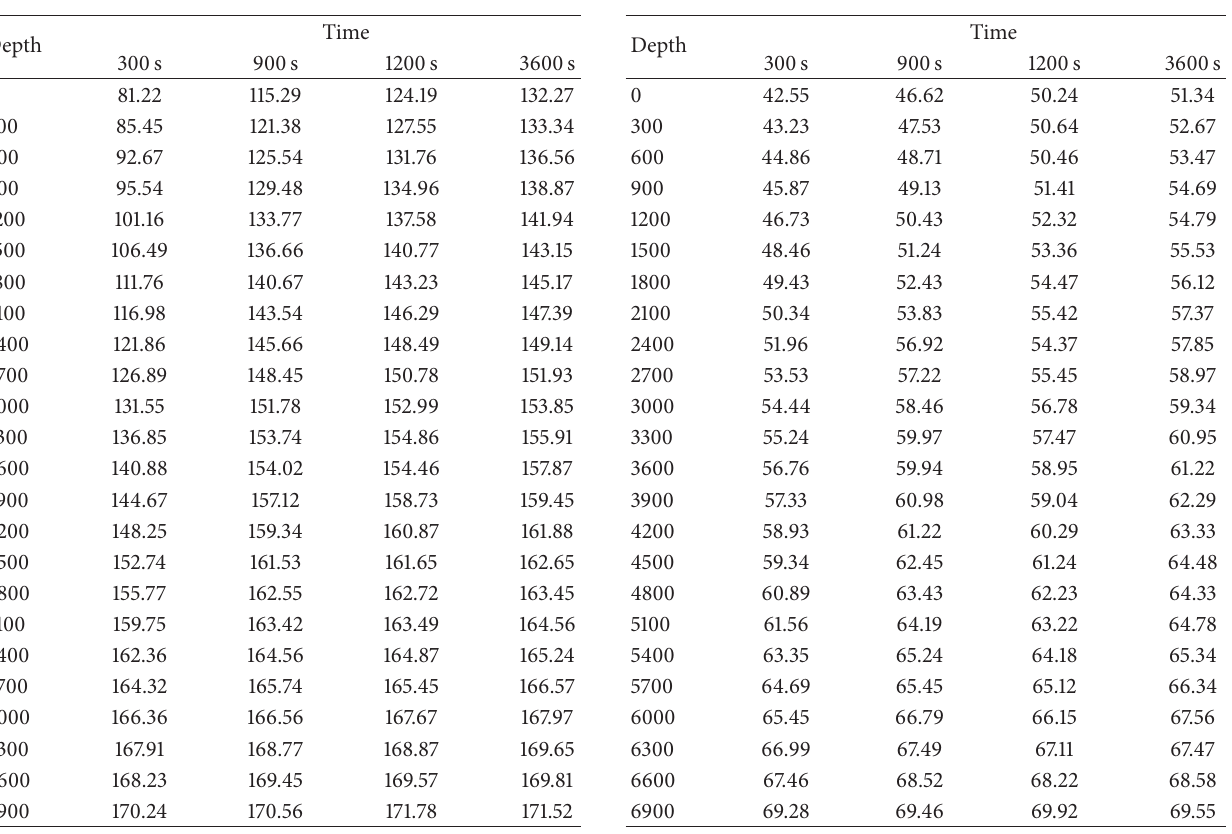
Table 3: Temperature at different depths on 300 s, 900s, 1200s, and 3600 s.